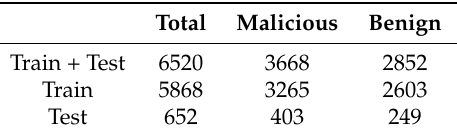
Table 2. Statistics of sampled data.